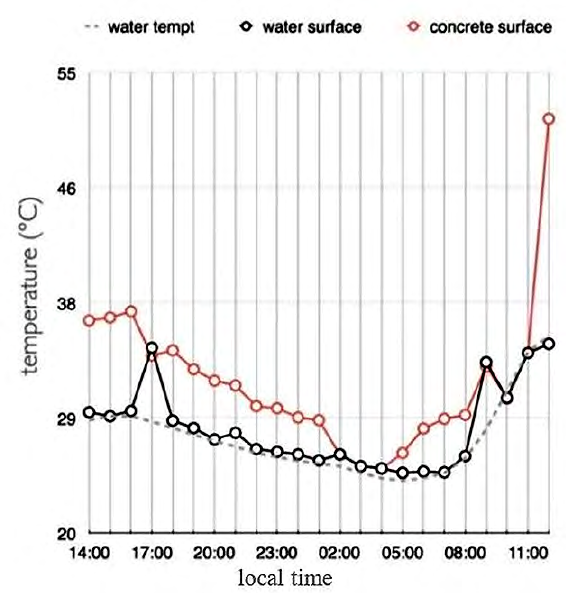
Figure 6. The comparison of measured surface temperature ( Ts ) of water and concrete (hourly average) taken from the thermal